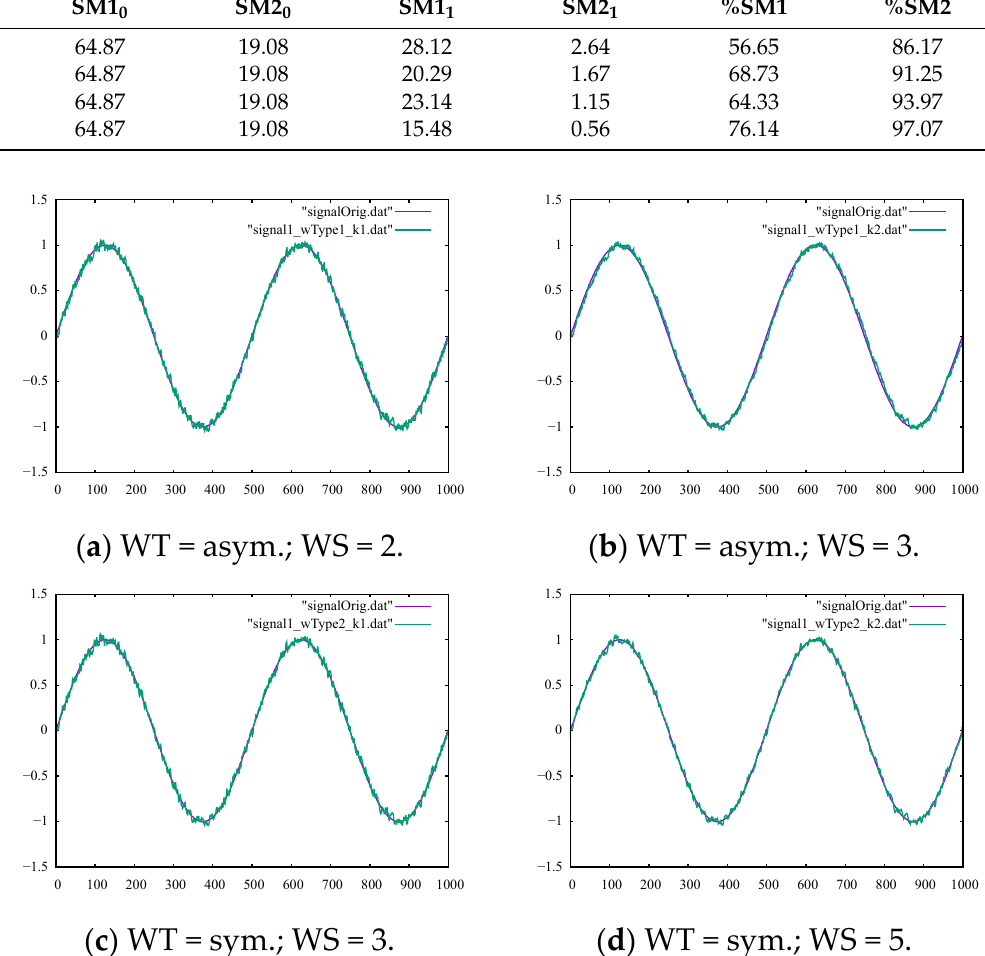
Figure 2. The output of the moving average filter with the ground-truth sine signal for comparison using ( a ) an asymmetric window of size 2, ( b ) an asymmetric window of size 3, ( c ) a symmetric window of size 3, and ( d ) a symmetric window of size 5.